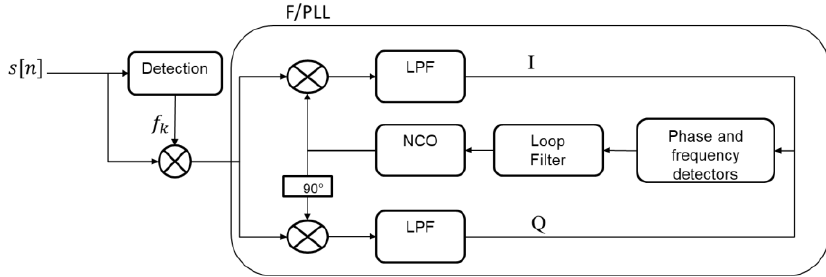
Figure 3. Principle of the tone detection and tracking.